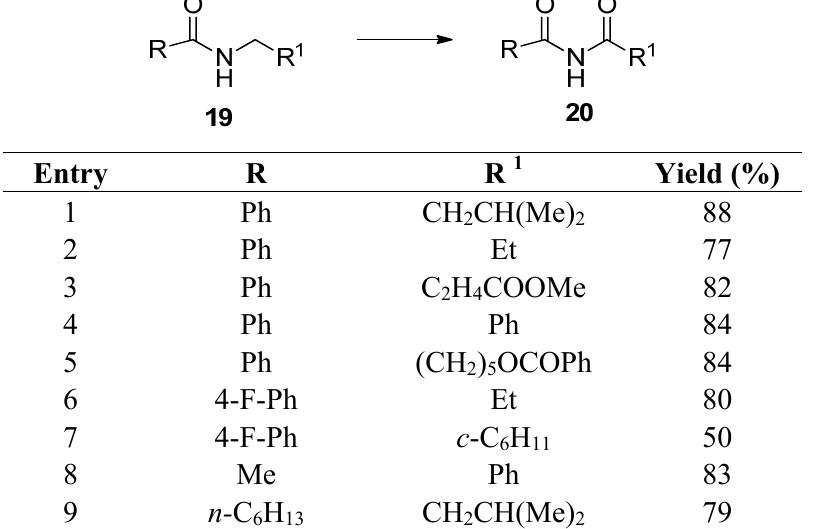
Table 1. Oxidation of amides 19 to imides 20 using Selectfluor F-TEDA-BF